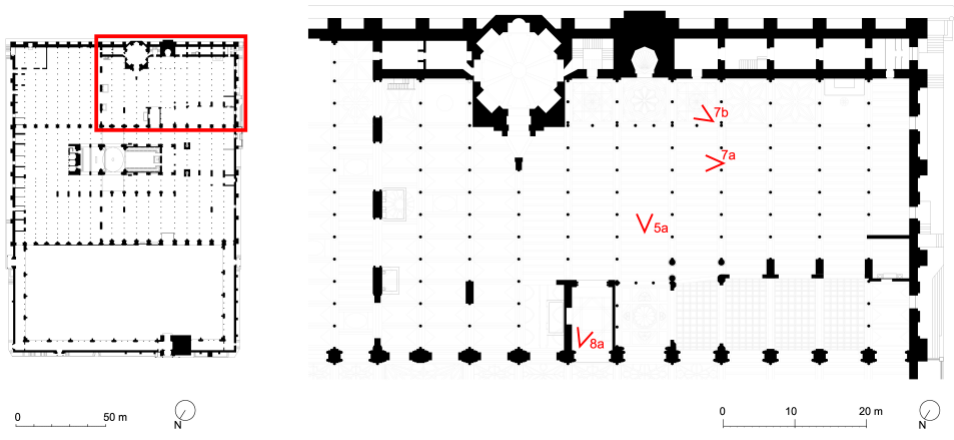
Figure 17. Location of Prangey’s viewpoints marked on the current plan. Source: Own image.